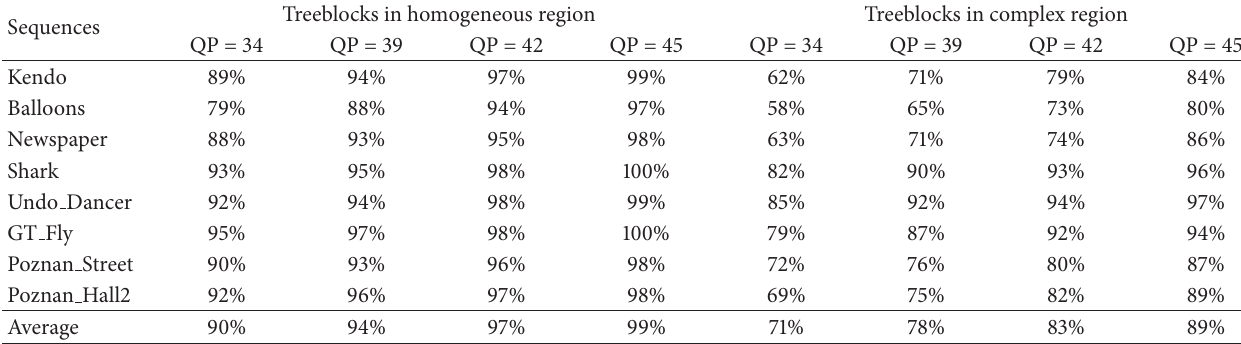
Table 4: Statistical analysis of accuracy for two treeblocks type.